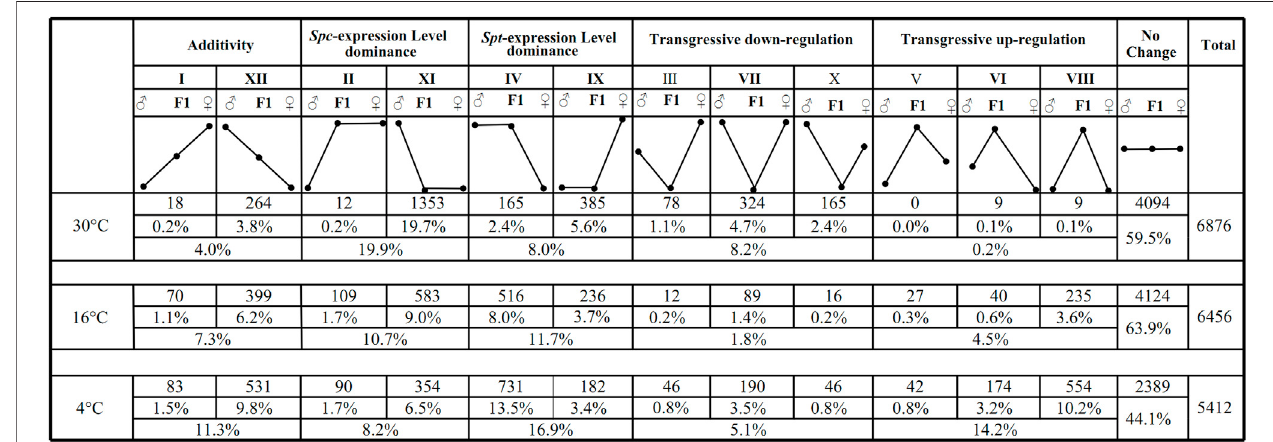
FIGURE 3 | The 13 possible expression patterns of F1 hybrids relative to the paternal parent S. trilobata ( _ ) and maternal parental S. calendulacea ( \ ) upon consecutive chilling stress (30 ° C, 16 ° C, 4 ° C). Each pattern is labelled with the same Roman numeral categorized as in Rapp et al. (2009). Statistically equivalent expressions were indicated with values on the same horizontal line, whereas statistically signi fi cant up- and down-regulation were represented by values on higher or lower horizontal lines, respectively. The 13 patterns are binned into fi ve categories representing “ no change ” , “ Spt -expression level dominance ” , “ Spc -expression level dominance ” , “ transgressive expression ” and “ additivity ” ,